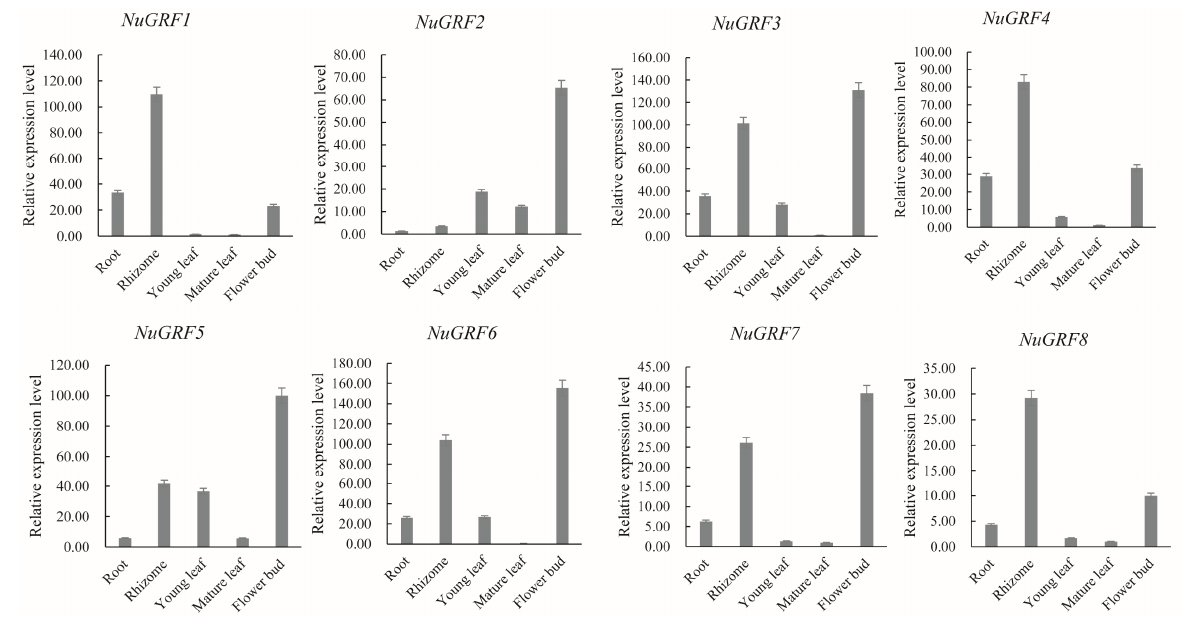
Figure 7. Expression profiles of different tissues of NuGRFs by qRT-PCR.